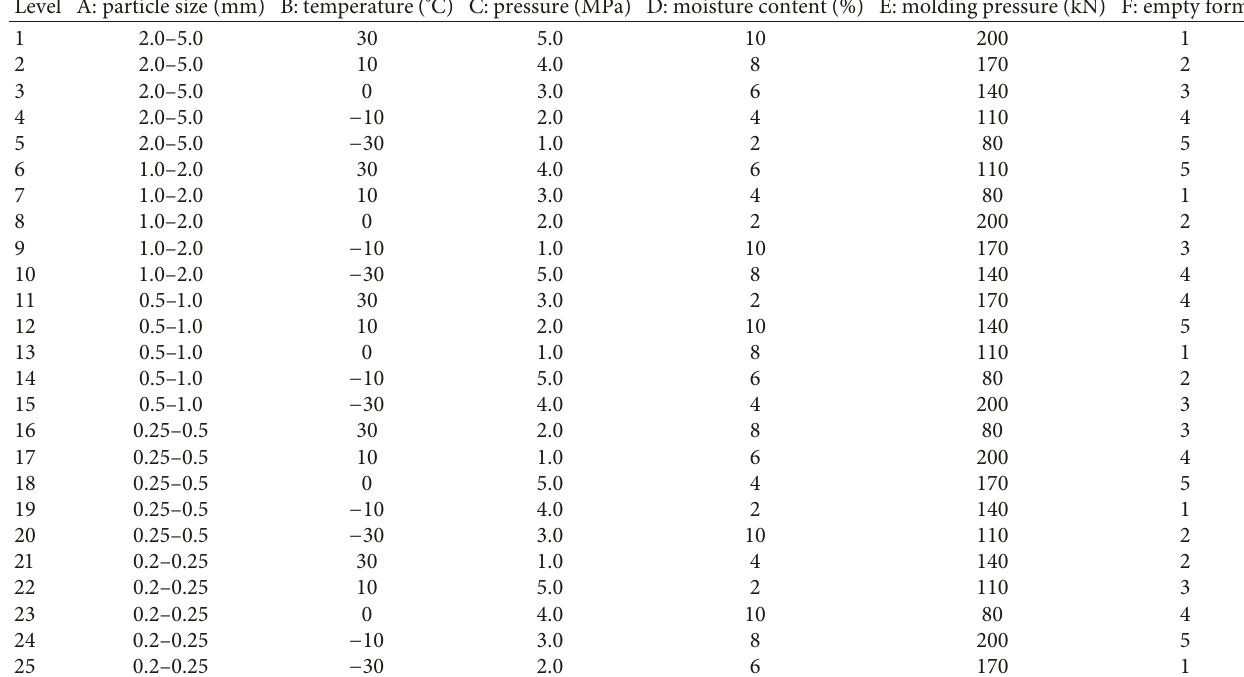
Table 3: Orthogonal experimental design.